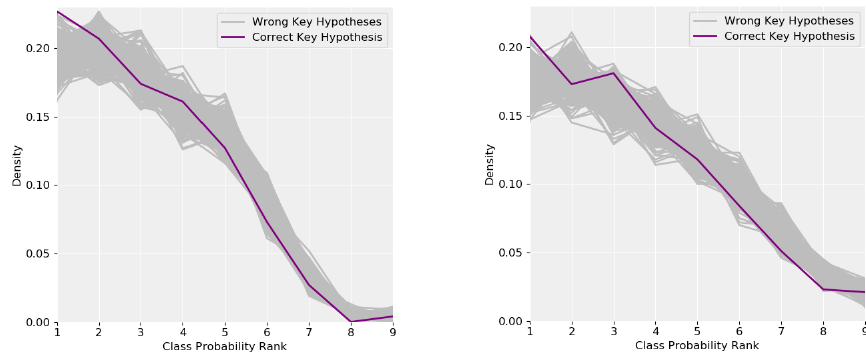
Figure 6: Rank of output class probabilities for two different groups of CNN hyperparam- eters on the same dataset (CHES CTF